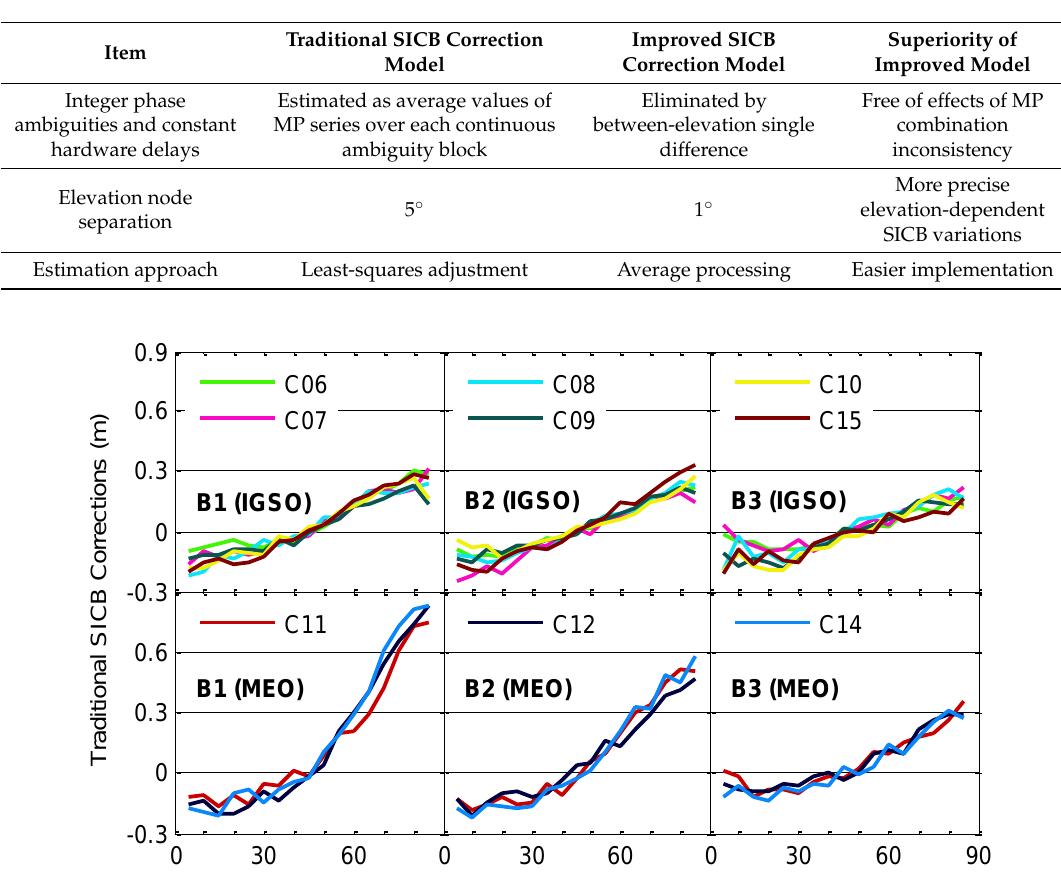
Table 1. Comparisons of the traditional and improved SICB correction models.